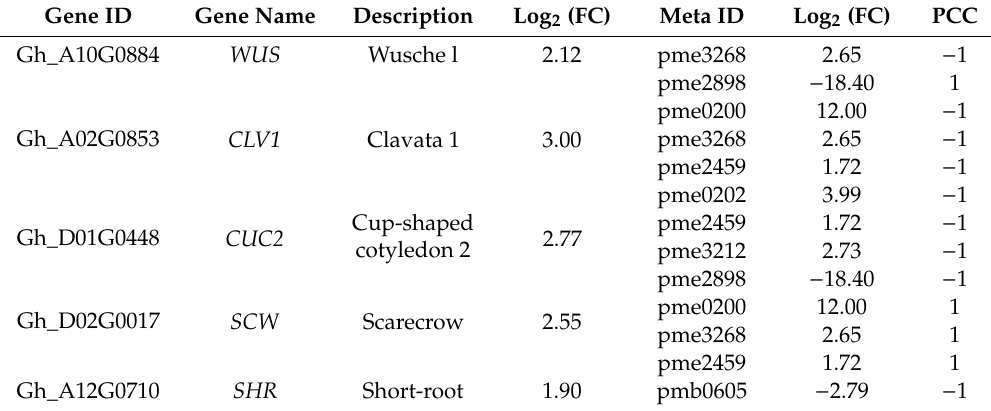
PEC, primary embryogenic calli; GE, initiation staged embryos with globular-like enriched.